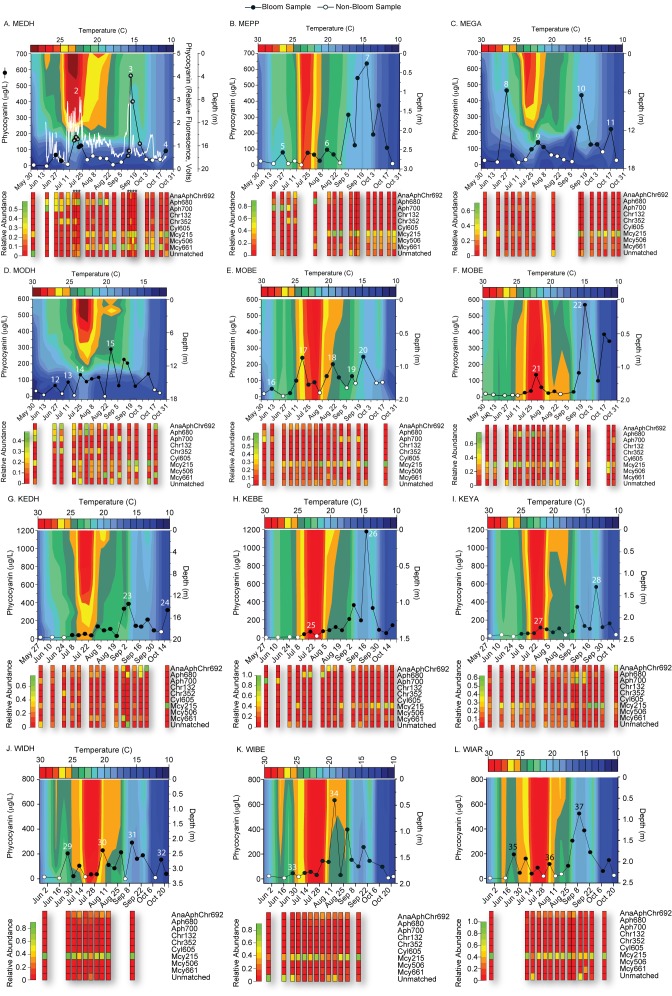
Trends in phycocyanin concentration (line graphs) and water temperature by depth (contour maps) compared to relative abundance of cyanobacterial taxa (bottom heat maps).Closed circles represent dates when a bloom was occurring. At the MEDH location an in- situ fluorometer attached to a monitoring buoy measured phycocyanin fluorescence once per minute (white line graph).